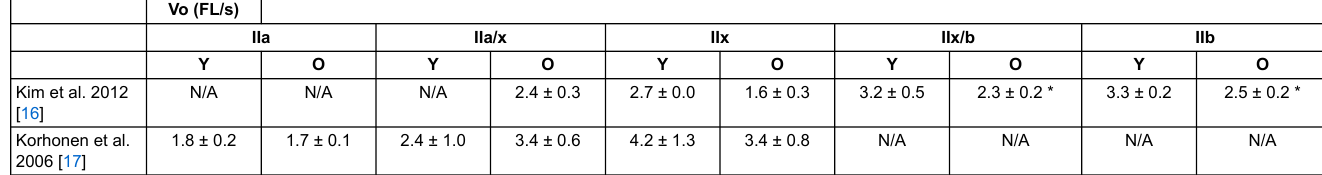
Table1: Shortening velocity of single muscle fibres between young and aged groups. Vo